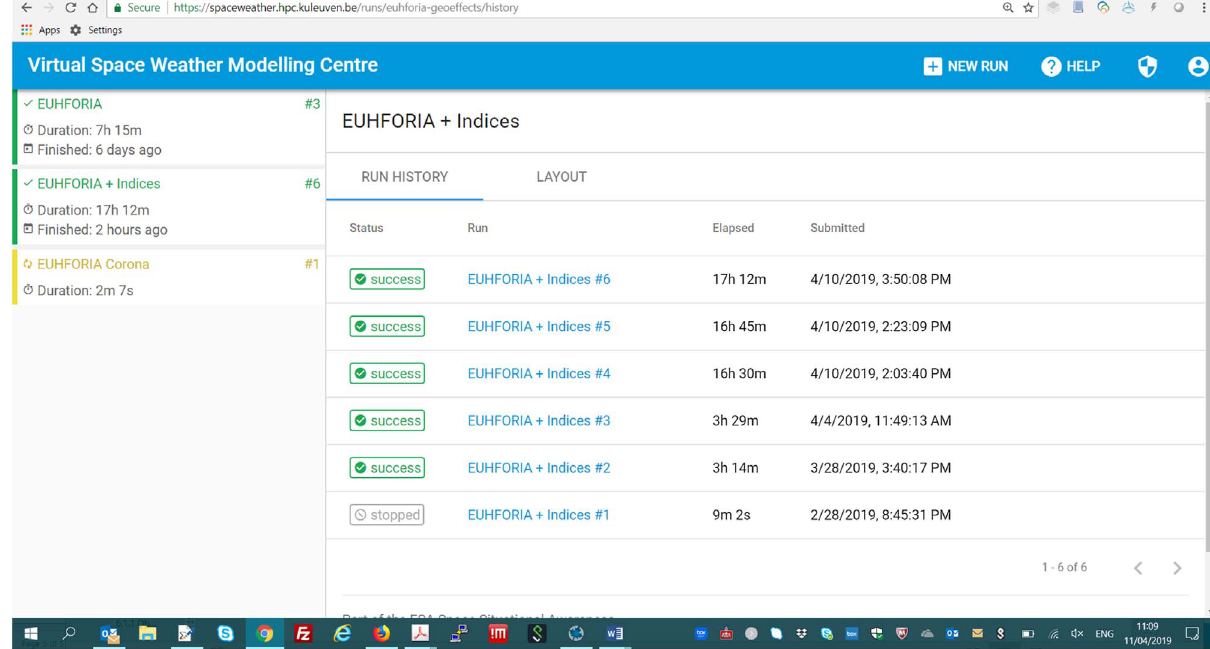
Fig. 9. Example of list of runs made with a certain model or model chain (in this case EUHFORIA +